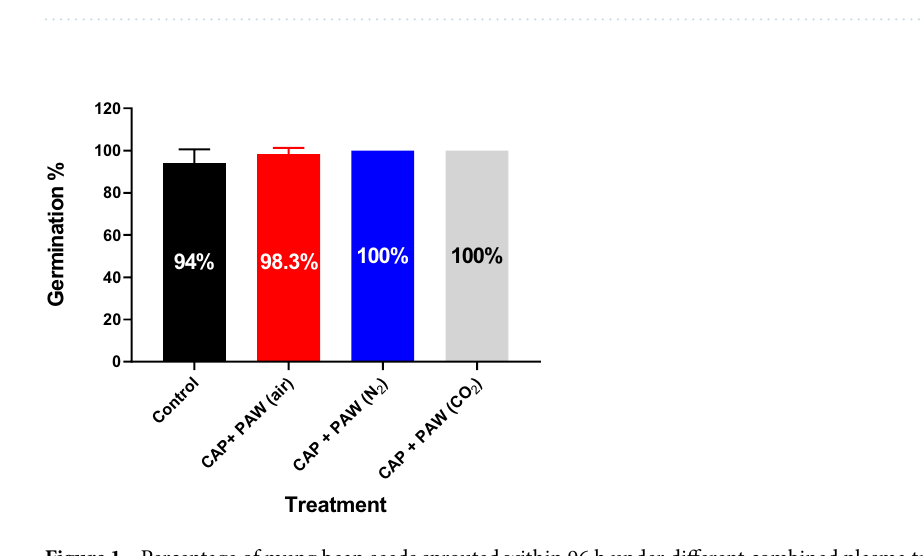
Table 2. Growth rate constant (k) and doubling time (Dt) of mung bean sprouts of sample replicates 1–3 for each combined plasma treatment obtained from exponential growth equation. Goodness of fit represented by R squared (R 2 ) value. Profile likelihood of each value demonstrated using 95% Confidence Interval (CI).